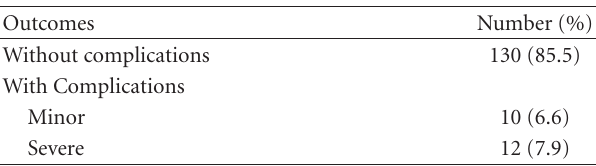
Table 2: Outcomes distribution in patients with mixed drug poisoning